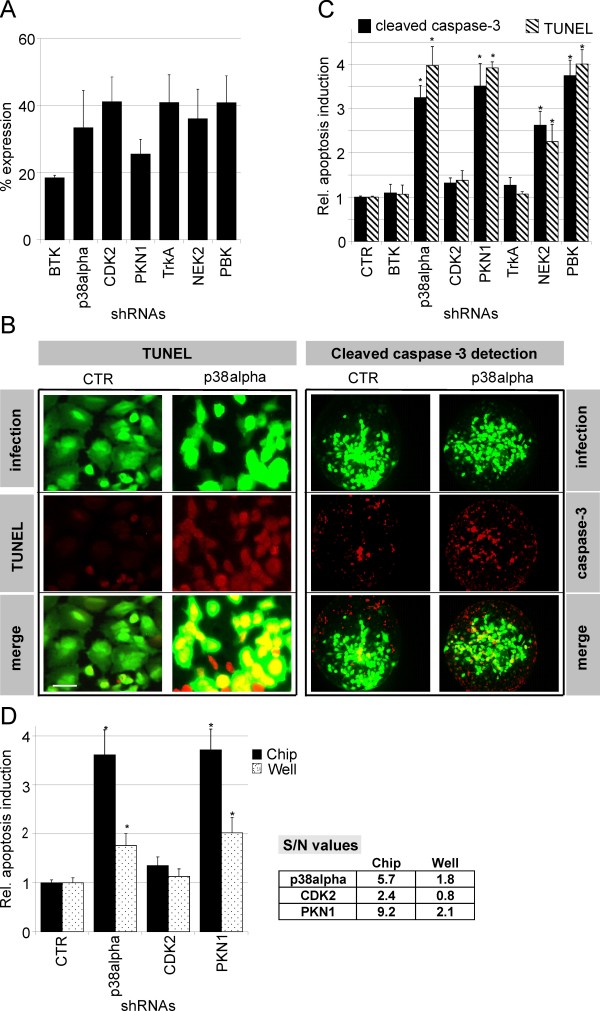
Detection of apoptosis induction in U-2 OS cells seeded on an adenoviral microarray. A. Relative expression levels of the target genes indicated after co-transfection of the psiCHECK marker plasmid and shRNA-encoding plasmids directed against the target genes indicated. B. TUNEL assay (left part of the image) or immunofluorescence of anti-cleaved caspase 3 (right part of the figure) of cells expressing EGFP and either control shRNA (left) or shRNA directed against p38alpha (right). Top, green fluorescence indicating infected cells; centre, red fluorescence for detection of TUNEL-positive cells or cells positive for cleaved caspase 3; bottom, merged images. Scale bar, 20 μm (for TUNEL) and 10 μm (for cleaved caspase 3 immunostaining). C. Functional assays performed on the microarray, using shRNA sequences directed against the target genes indicated. Caspase 3 (black bars) or TUNEL signal (hatched bars) were quantified in U-2 OS cells (ImageJ software). The statistical significance is marked by asterisks (4 spots, n > 150, p < 0.005, three independent experiments; by ANOVA analysis). D. Comparison of caspase 3 activation using either immunodetection on the microarray (black bars), or detection of enzymatic caspase 3 activity in cell lysates (Caspase-3-Glo, in a 96-well format (hatched bars). Statistical significance is marked by asterisks (4 spots, n > 150, p < 0.005, three independent experiments; by ANOVA analysis). On the right, the calculations of signal-to-noise ratios are shown.